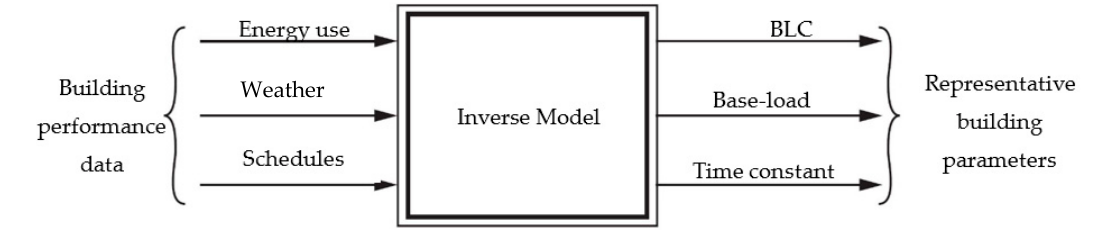
Figure 2. Basic approach of a typical inverse energy analysis model [46].